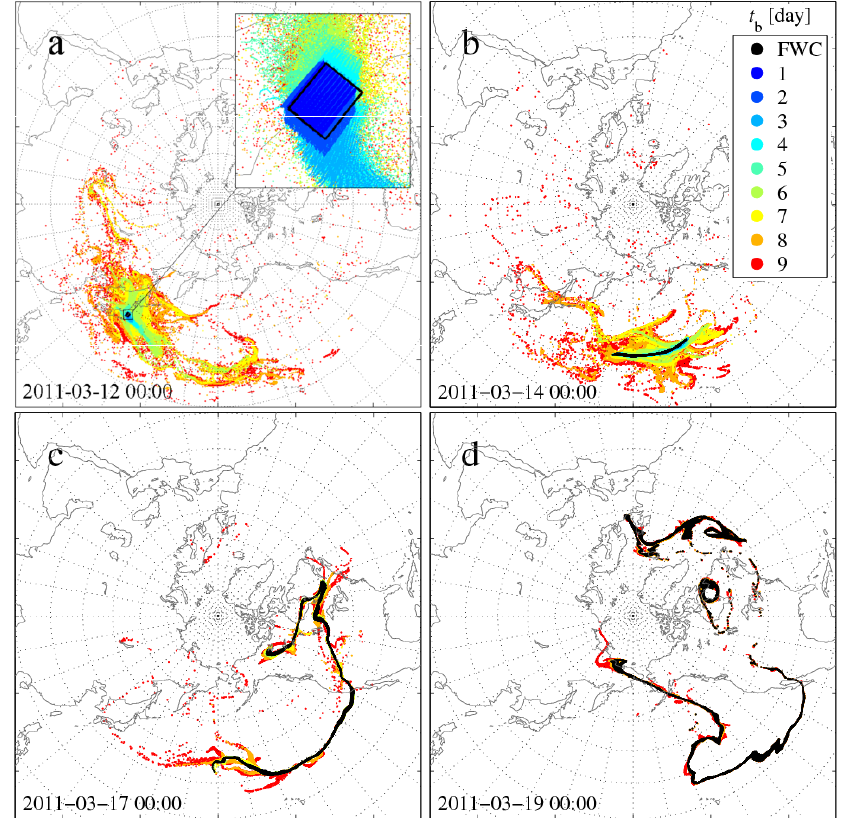
Figure 3. Forward (black) and backward (colored) pollutant clouds emitted instantaneously and consisting of n 0 = 1.25 × 10 5 particles of the case study at ( a ) t = 0, ( b ) t = 2, ( c ) t = 5 and ( d ) t = 7 days. The forward pollutant cloud is initiated on 12 March 2011 at 00 UTC at 141 ◦ E, 37.5 ◦ N, 500 hPa in a 1 ◦ × 1 ◦ × 100 hPa cuboid beyond Fukushima. Dots colored according to the color bar on the right denote the location of the particles whose backward simulation started at time t b (day). In the inset of panel (a), instead of black dots, the initial position of the particles is illustrated by a black rectangular frame. For better visibility, only every fifth particle of the clouds is